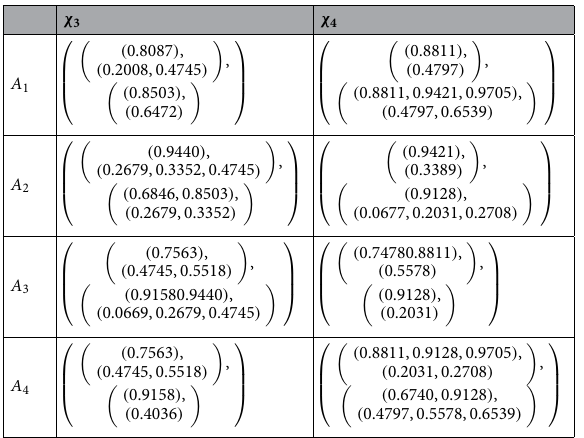
Table 9. Weighted information (EWG).